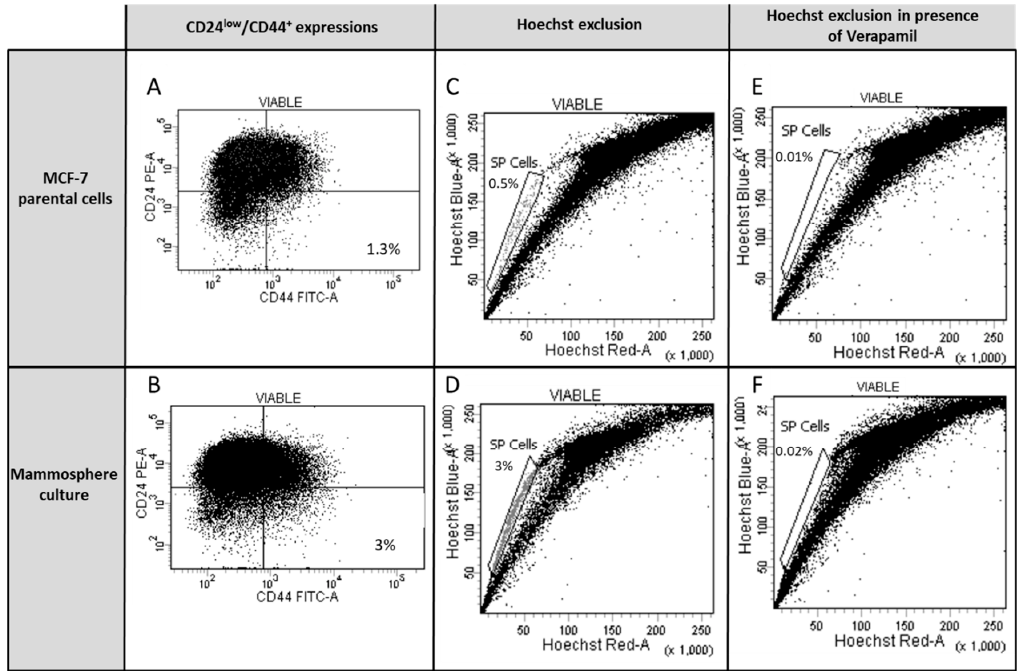
Figure 8. Characterization of the expression of CD24low/CD44+ and the side-population (SP) cells in parental MCF-7 cells and mammospheres. To determine CD24low/CD44+ expression in ( A ) MCF-7 cells and ( B ) mammospheres, cells were incubated with anti-CD24 (PE) and anti-CD44 (FITC) or isotype controls. The SP cells were analyzed without ABC transporter inhibitor Verapamil in ( C ) MCF-7 cells and ( D ) mammospheres, or with 50 µM of Verapamil in ( E ) MCF-7 and ( F ) mammospheres by Hoechst 33342 staining and flow cytometry.